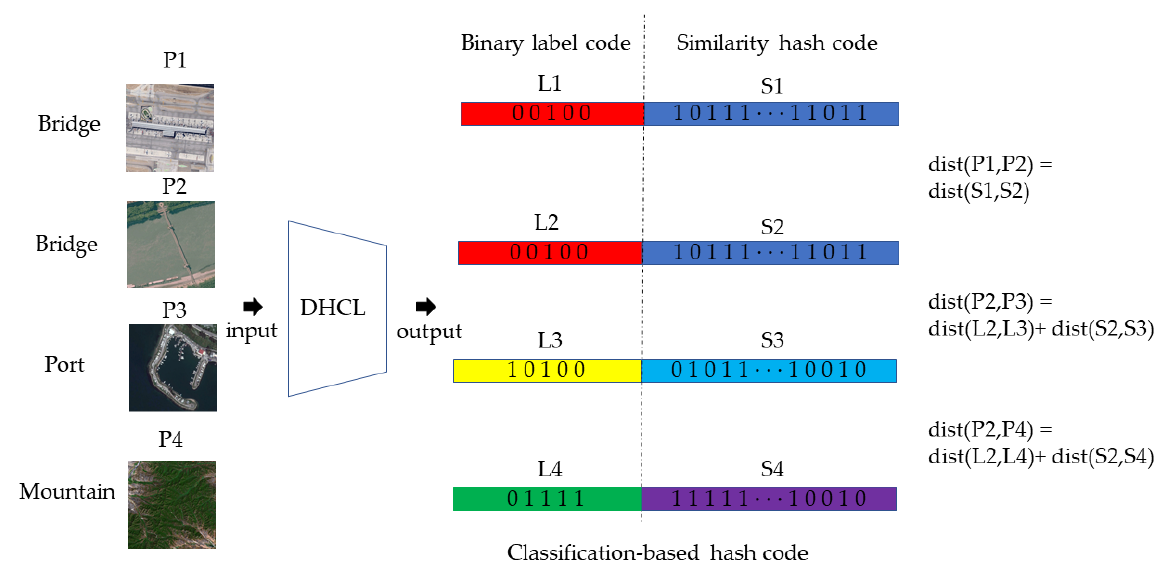
Figure 1. The working flow of classification-based hash codes. Assume that four images, P1, P2, P3 and P4, are given, with their labels on the left. Inputting them into DHCL, the classification-based hash codes would be generated. The left side of the dotted line is the binary label codes, and the right side is the similarity hash codes. For P1 and P2, which are predicted to be of the same class, the distance between the binary label codes is 0, and only the distance between the similarity hash codes needs to be considered. For P2 and P3, which are predicted to be of the different class, the binary label codes can assist similarity hash codes in increasing the distance. When the classification-based hash codes are adopted in the training stage, it would be helpful to build the final embedding space. Moreover, by comparing dist ( P2,P3 ) and dist ( P2,P4 ) , we can find that binary label codes and can learn the distribution of different classes in Hamming